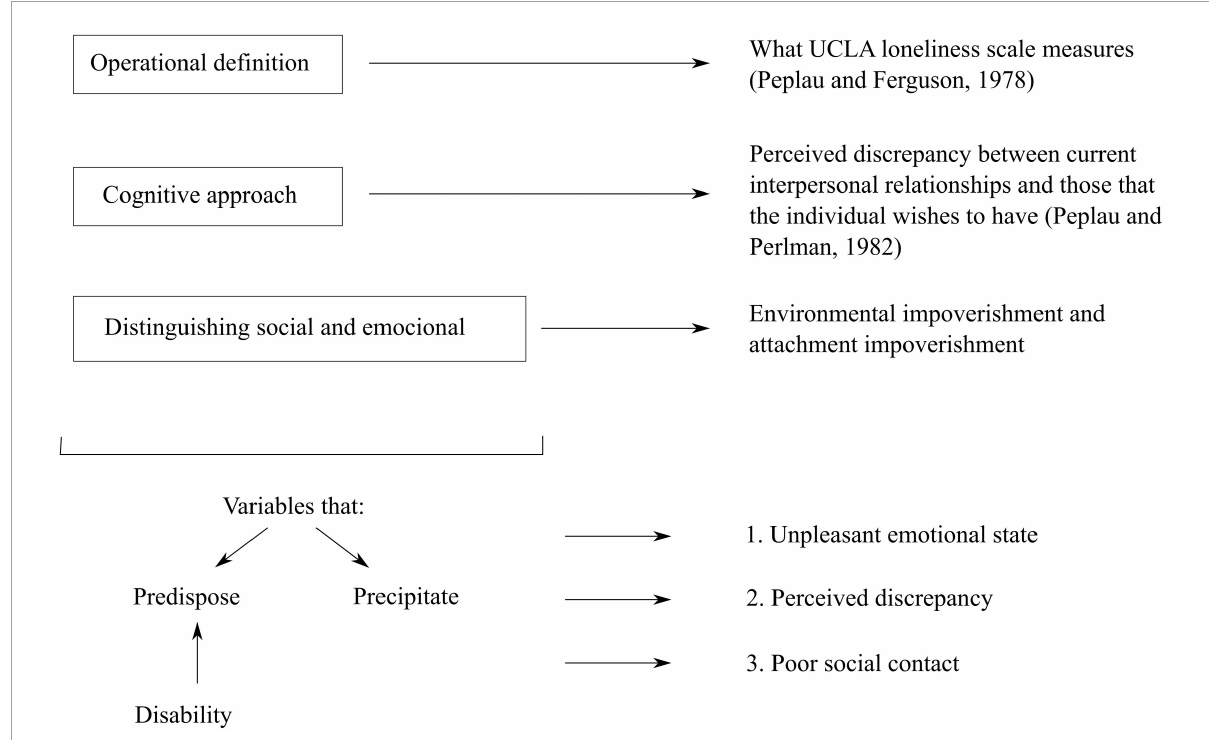
FIGURE3 Diagram on the concept of